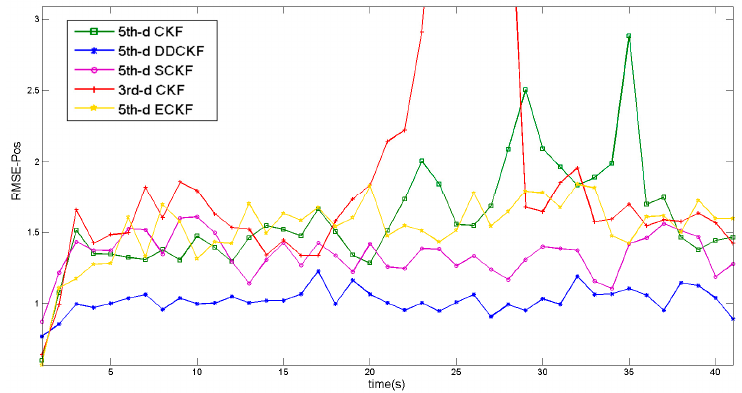
Figure 1. RMSE for different filters in Experiment 4.1.1.